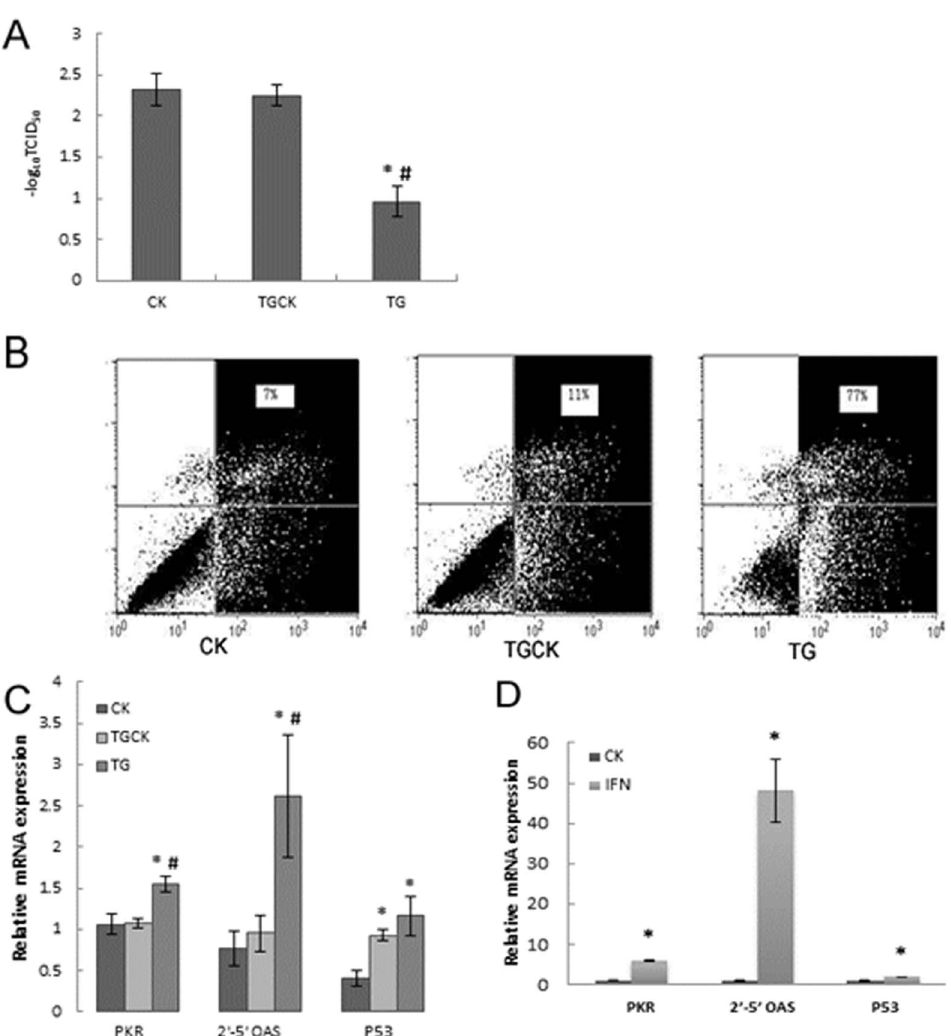
Figure 3. Antiviral activity and apoptosis mediated by hIFN- a in transfected bovine fetal fibroblasts. After VSV infection for 2 h, fibroblasts were cultured in normal medium (without virus) for a further 72 h. (A) Virus titres (TCID 50) in the supernatant of wild-type (CK), control vector (peGFP-N1 vector) transfected (TGCK), and hIFN- a transfected (TG) bovine fetal fibroblasts. (B) Apoptosis was determined by FITC-conjugated annexin V and propidium iodide (PI) staining. The y-axis is PI and the x-axis is FITC-annexin V. (C) The expression levels of PKR , 2 9 -5 9 OAS , and P53 mRNA were analyzed using real-time RT-PCR with results normalized to the expression levels of GAPDH . (D) The expression levels of PKR , 2 9 -5 9 OAS , and P53 mRNA in wild-type bovine fetal fibroblasts after 5 6 10 2 5 m g rhIFN- a -2b/mL was added to the culture medium for 2 h, analyzed by qRT-PCR with results normalized to expression levels of GAPDH . Data are shown as means 6 SD from three independent experiments. * P , 0.05 vs. CK group; # P , 0.05 TG vs. TGCK. PKR , double-stranded RNA-activated protein kinase gene; 2 9 -5 9 OAS , 2 9 -5 9 -oligoadenylate synthetase gene.